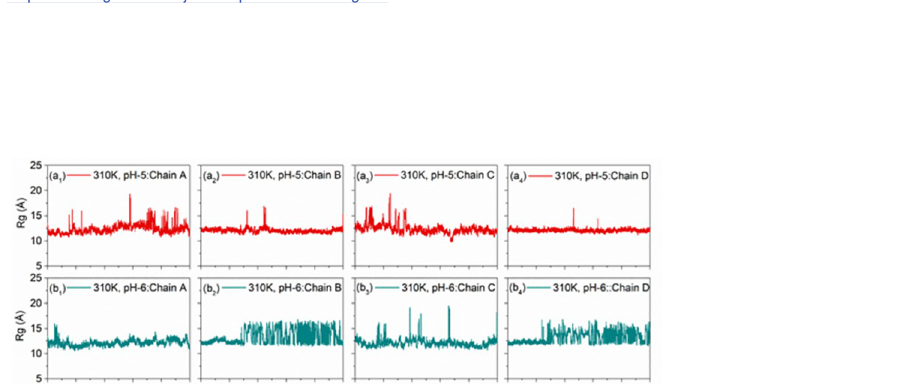
Fig 11. Variation of radius of gyration (Rg) of all the strands of the DNA Junction with simulation time at 300K with altered pH, viz. (a 1 -a 4 ) pH5, (b 1 -b 4 ) pH6, (c 1 -c 4 ) pH7 as reference, (d 1 -d 4 ) pH8, and (e 1 -e 4 ) pH9.